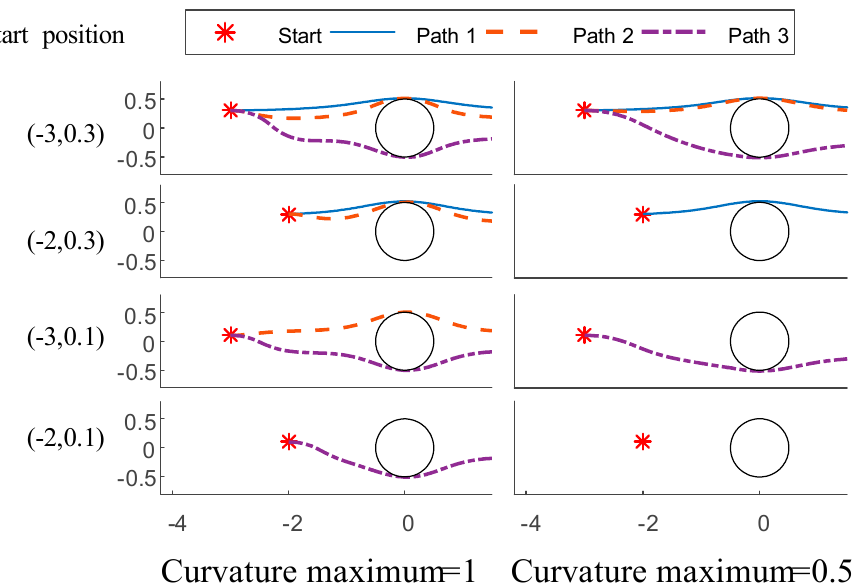
Figure 9. The single obstacle avoidance path for different start positions and the curvature maximum constraint in the x - y plane. The radius of the obstacle is 0.5 m. The robot forward moving direction is the positive x -axis (toward the right).